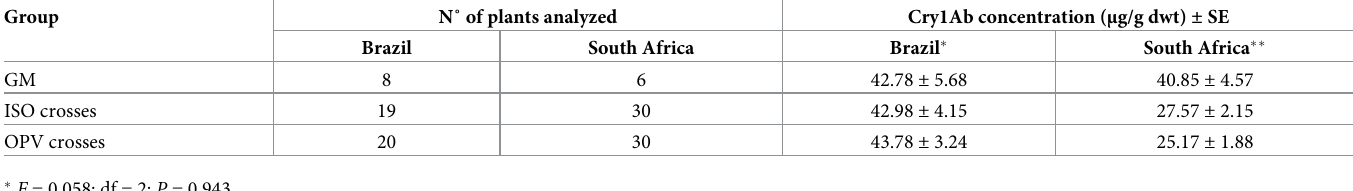
Table 4. Number of maize plants analyzed, mean and standard error ( ± SE)of the Cry1Ab protein concentration in the main genetic background groups from Brazil and South Africa.